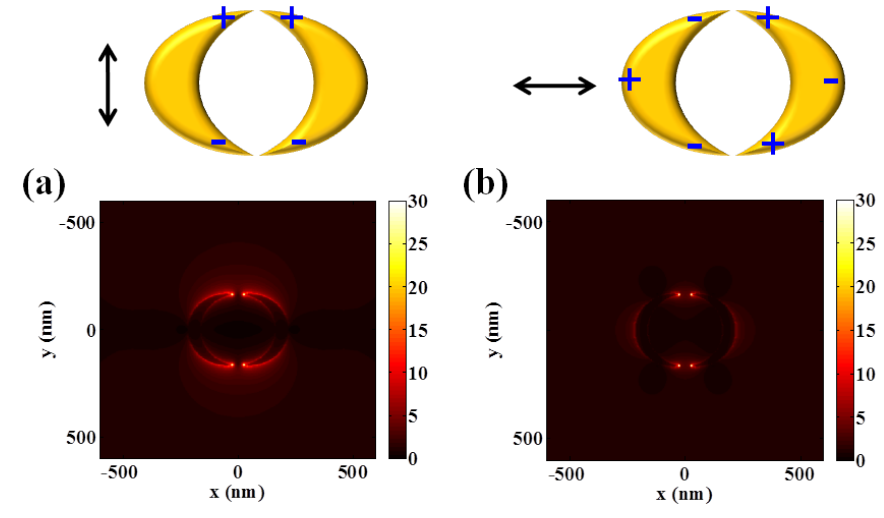
Figure 6. Intensity distributions (arbitrary unit) of double-crescents with respect to incident polarization state of light: (a) vertically polarized light and (b) horizontally polarized light. The width of a nanocrescent is fixed to 50